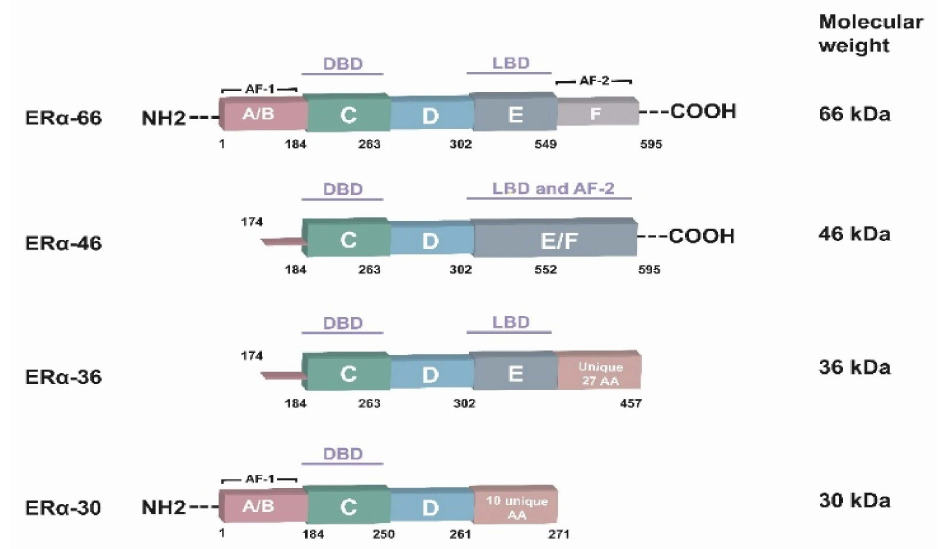
Figure 2. Schematic representation of ER α isoforms including ER α -66, ER α -46, ER α 36, and ER α - 30. (DBD: DNA-binding domain; LBD: ligand-binding domain; AF-1: activation domain-1; AF-2 activation